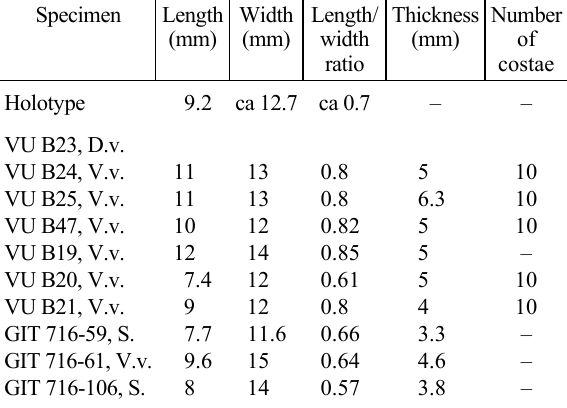
Table 1. Measurements of shells. D.v., dorsal valve; V.v., ventral